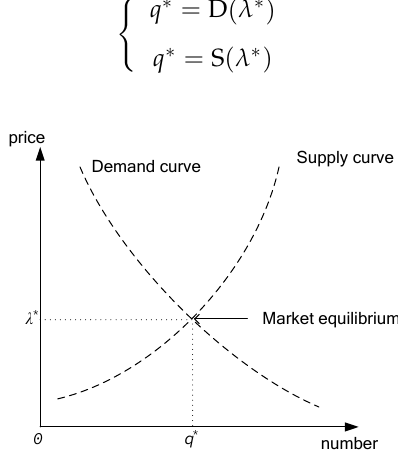
Figure 2. The supply and demand curves.